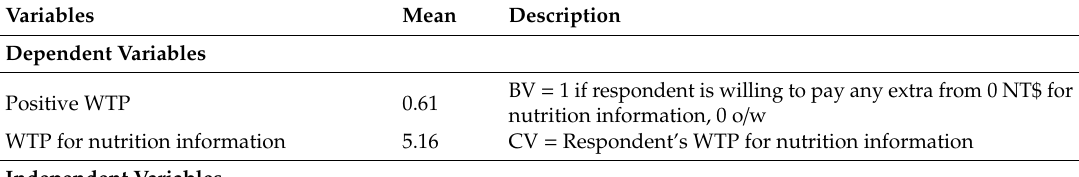
Table 1. The description of sample statistics of variables ( N =